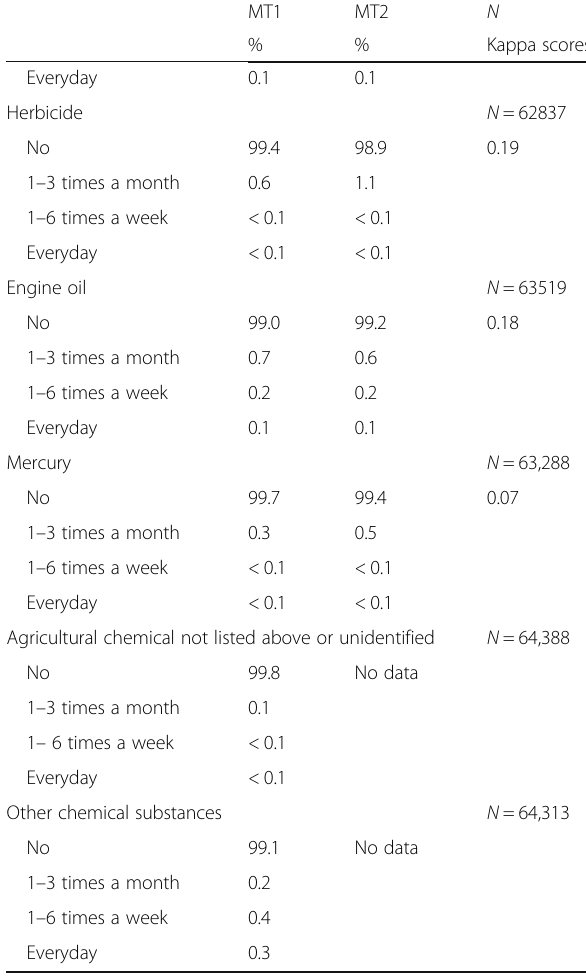
Table 3 Frequency of the occupational use of chemicals for more than half a day during pregnancy (MT1 and MT2 questionnaires)